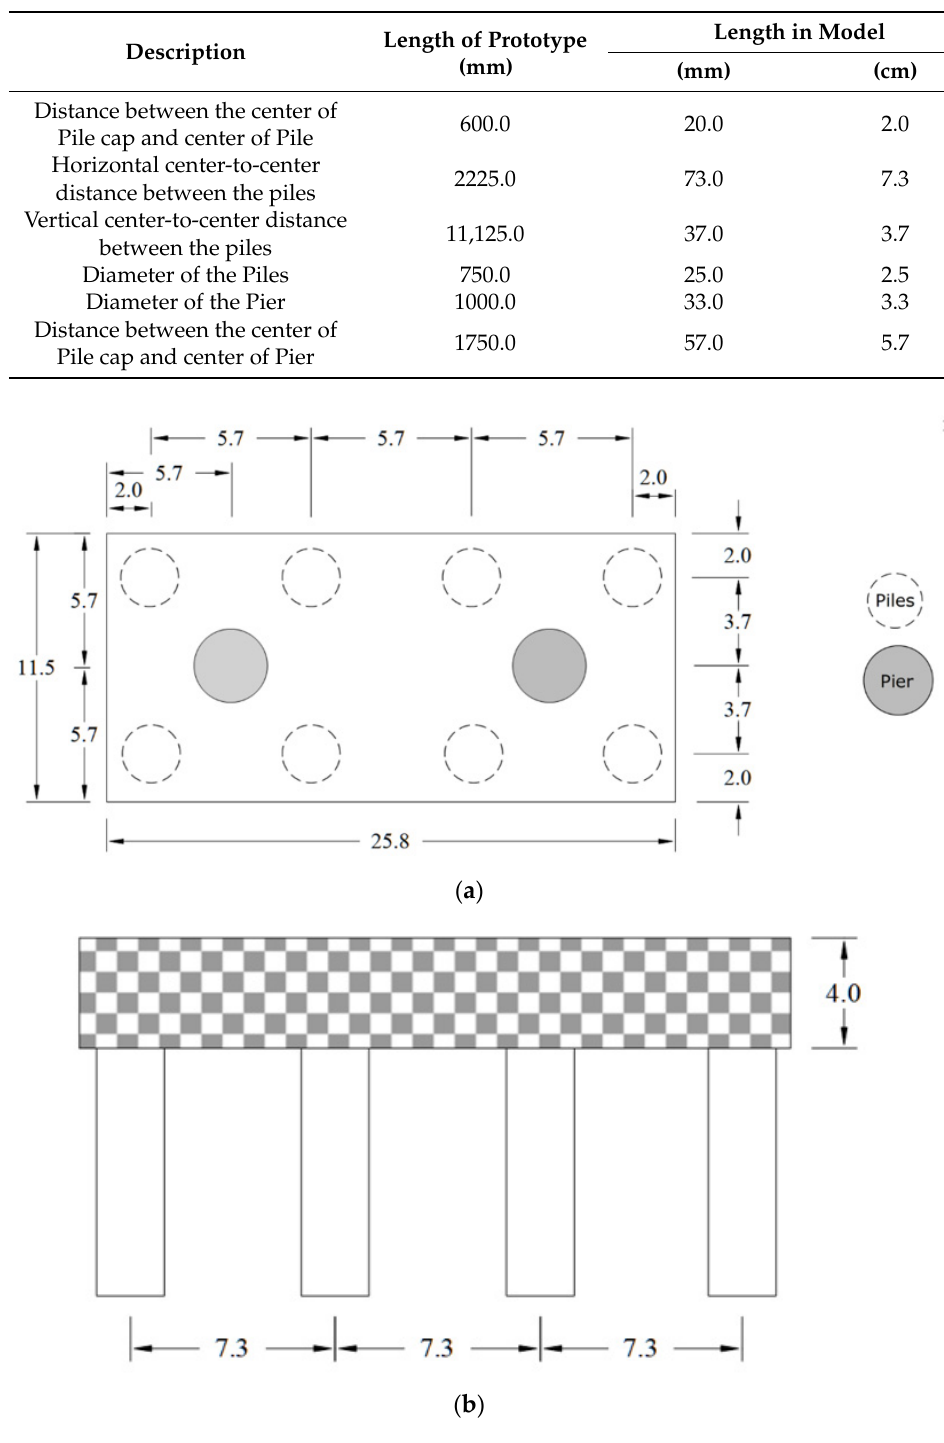
Figure 4. Systematic diagram of model (all dimensions are in cm): ( a ) plan; ( b ) elevation.